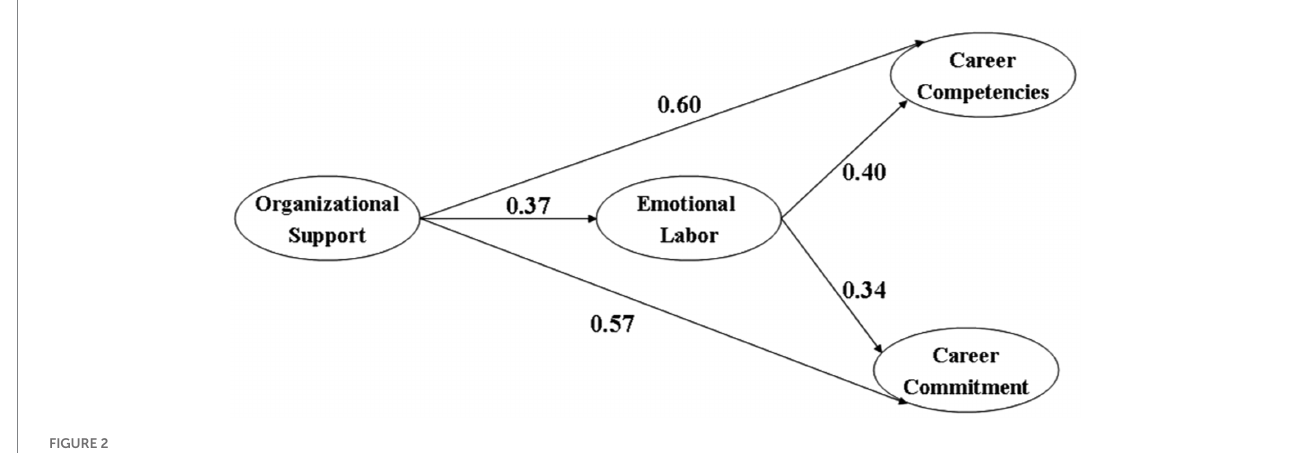
FIGURE 2 Estimated measurement